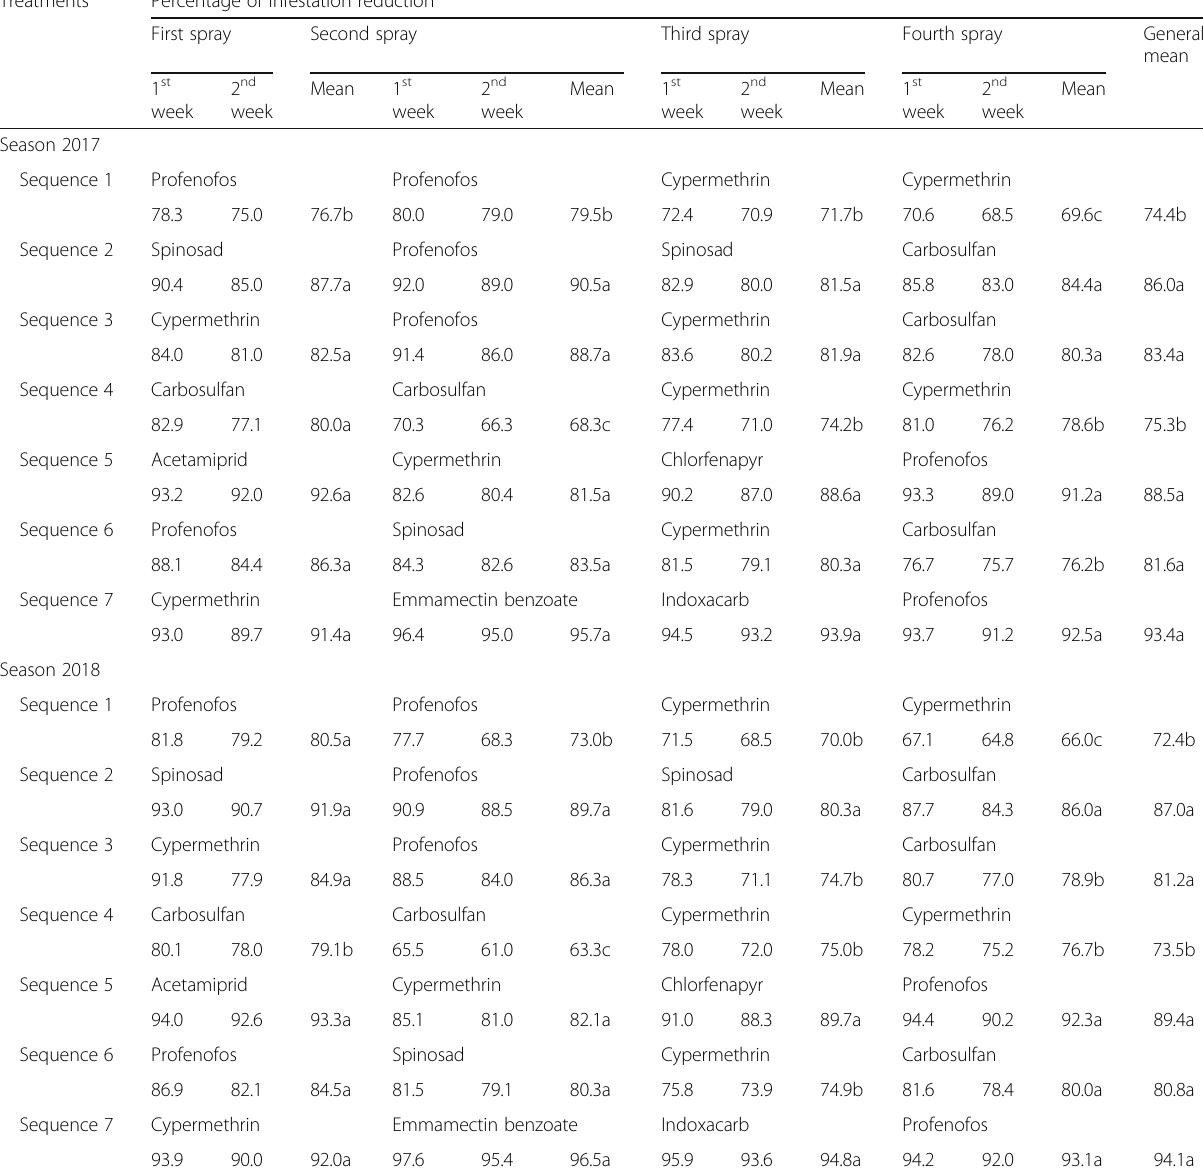
Table 2 Infestation reduction percentage of Pectinophora gossypiella during two seasons Treatments Percentage of infestation